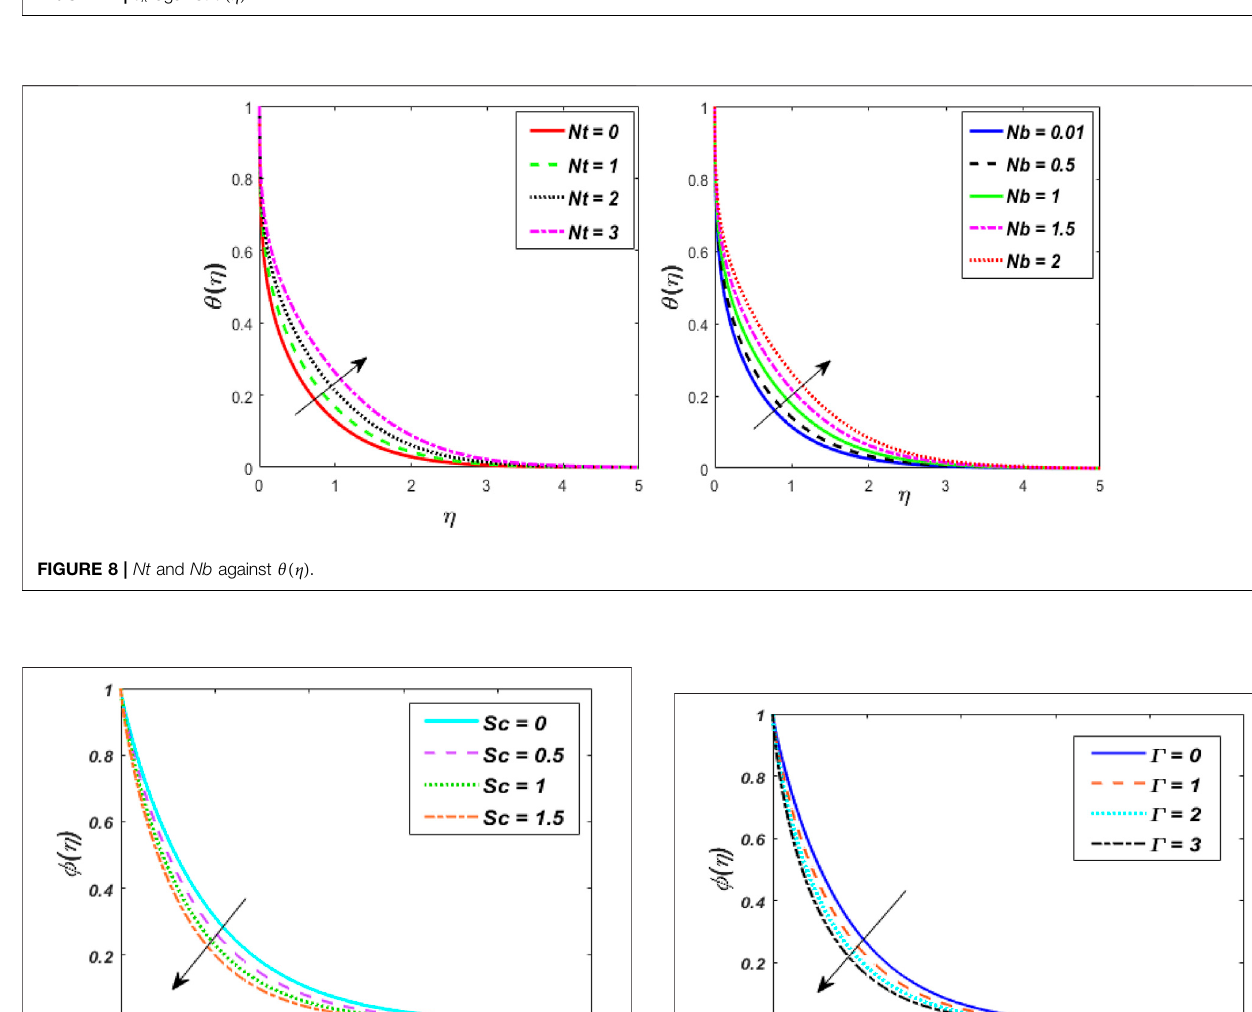
FIGURE 7 | δ k against θ ( η )